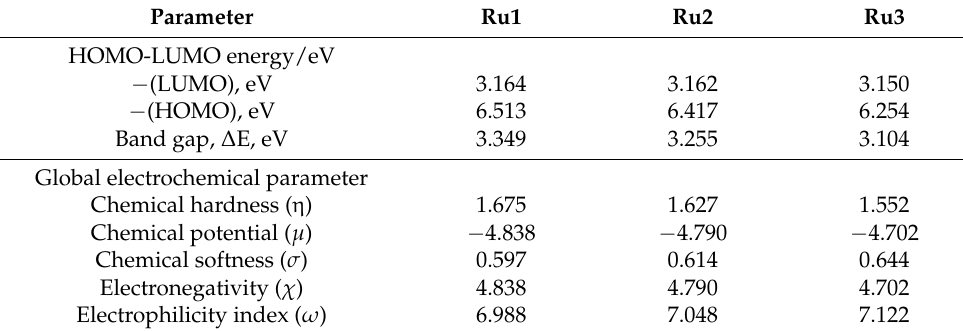
Table 3. DFT-calculated data for complexes Ru1 - 3